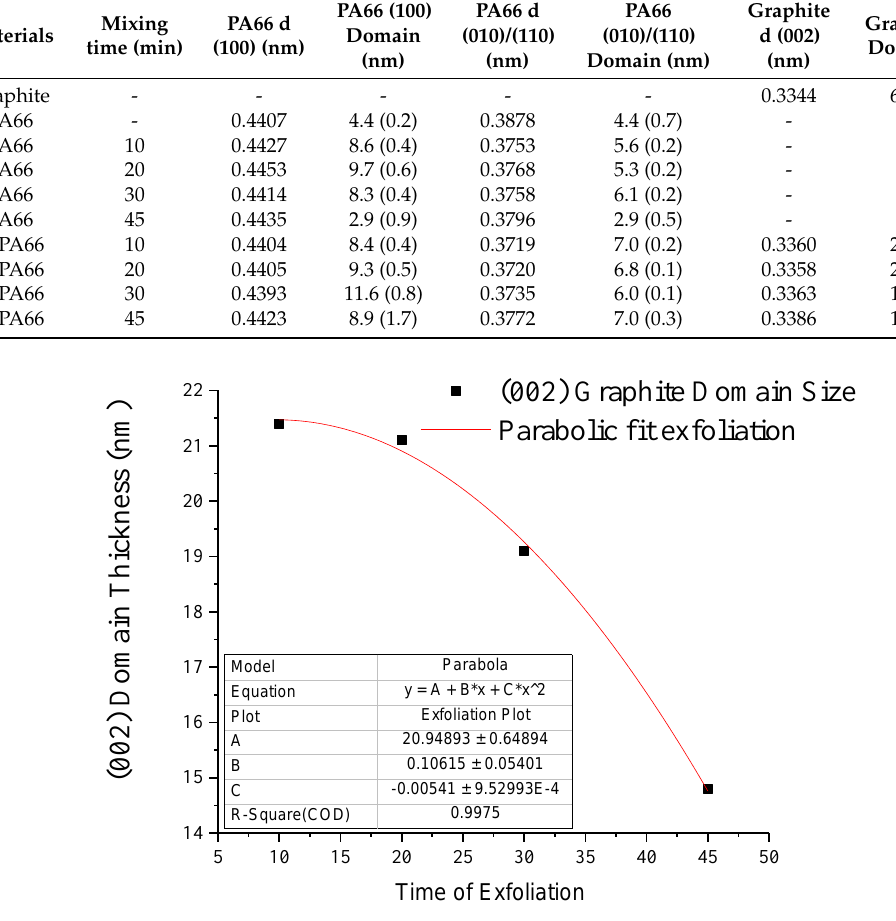
Figure 2. Graphite (002) domain size curve fit.